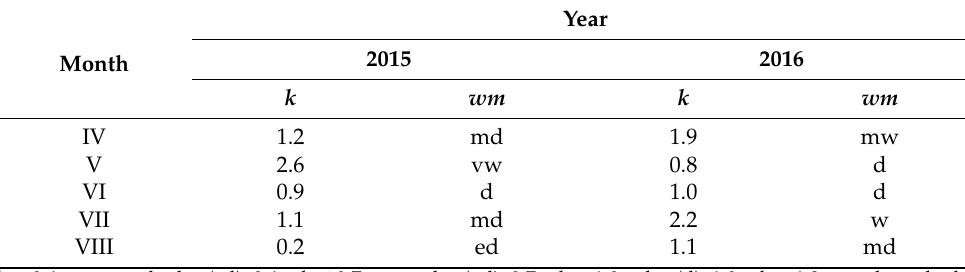
Table 2. Values of the Selyaninov hydrothermal index ( k ) during the vegetation periods of pea and spring barley and moisture characteristics ( wm ) of individual